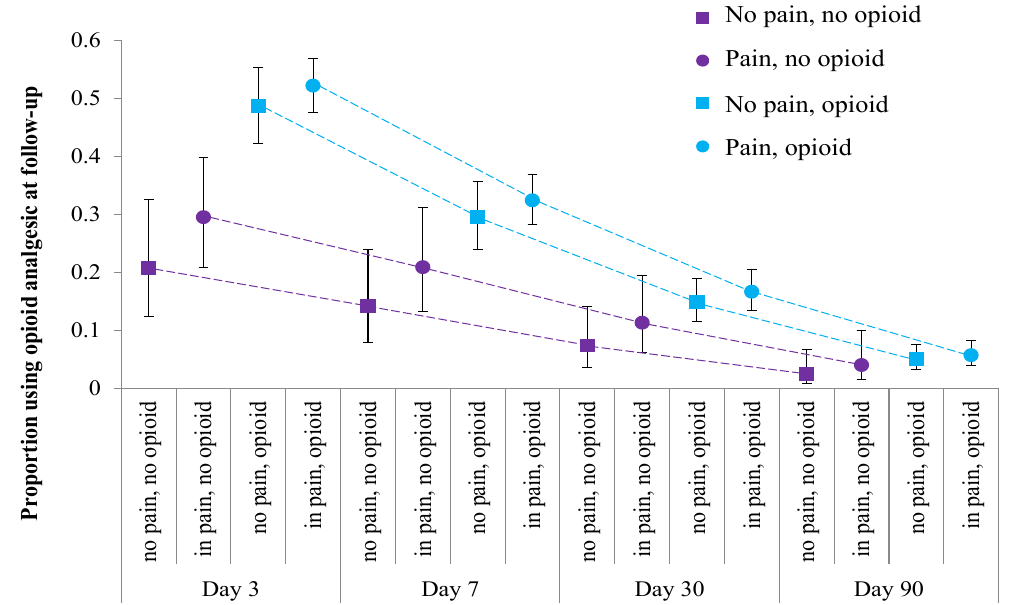
Figure 2. Adjusted proportion (95% confidence interval (in whiskers) of participants reporting pain at follow-up visits by cohort estimated by multivariable model adjusted for propensity to receive an opioid analgesic prescription, stratified by pain reported and prescription of opioid analgesic at emergency department discharge. Sample includes 3,568 follow-up observations for 892 adults with urolithiasis seen at one of 15 emergency departments in the STONE trial. STONE, Study of Tomography of Nephrolithiasis